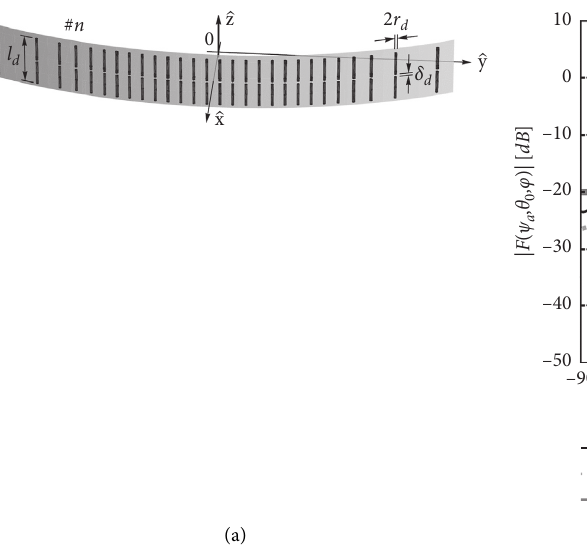
Figure 11: Synthesized sparse 24 λ -long arc array aperture with curvature radius of 30 λ and 28 antenna elements that features an HPBW of 6 degrees and SLL of − 20dB [59]: (a) physical implementation where each array element is a 0.425 λ long dipole antenna with 0.0125 λ radius and 0.005 λ feeding delta gap; (b) magnitude of the array radiation pattern.